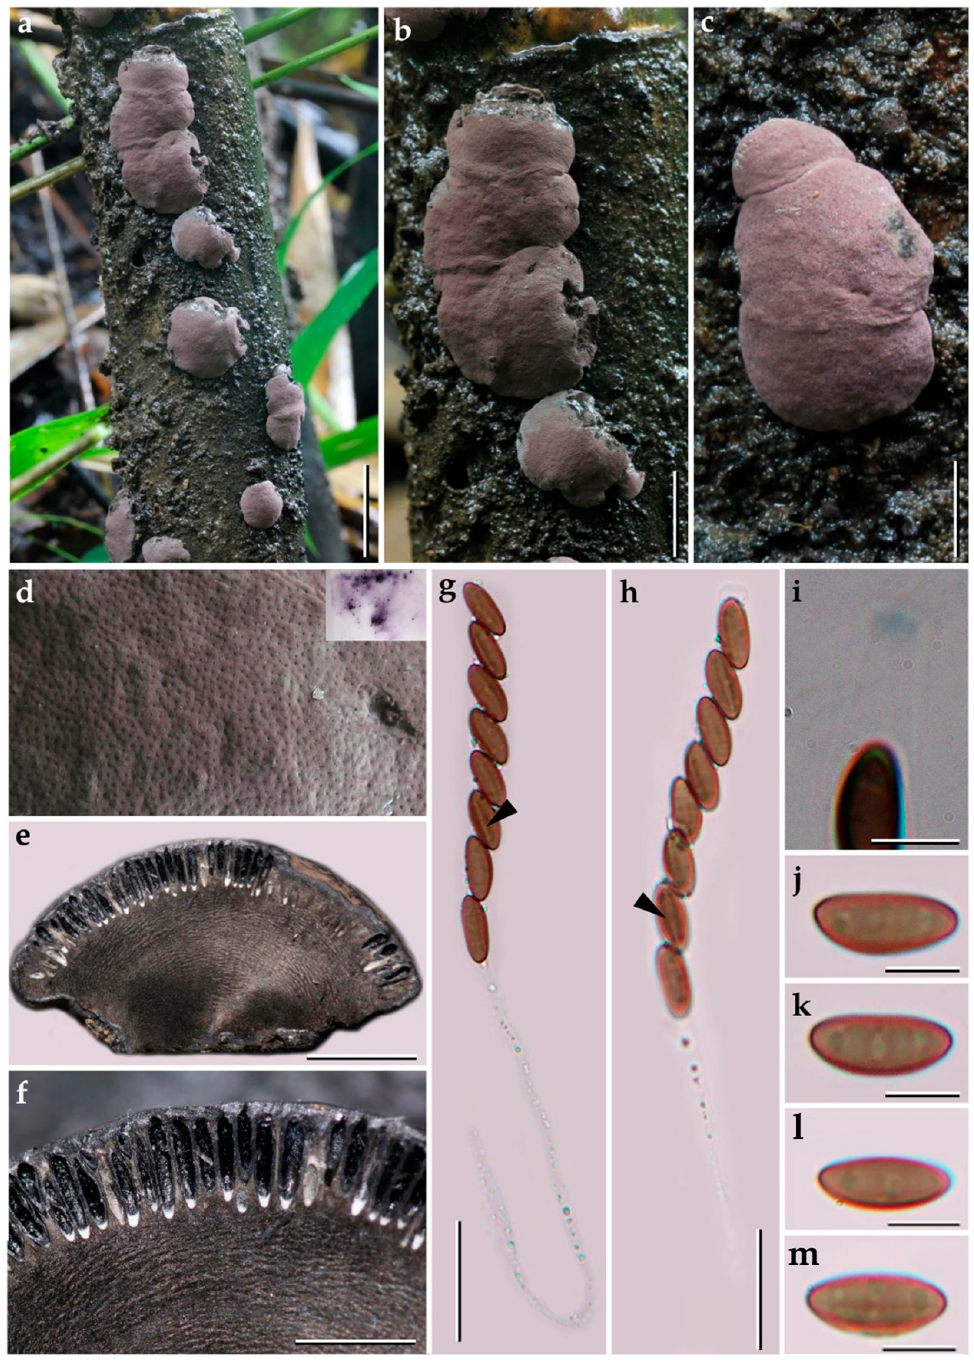
Figure 4. Morphological characteristics of Pyrenopolyporus bambusicola (BBH47923). ( a – c ) Stroma on bamboos; ( d ) stromal surface and ostioles with KOH-extractable pigments in 10% KOH; ( e ) longitudinal section of stroma showing perithecia and the tissue below the perithecial layer; ( f ) Perithecia; ( g , h ) asci showing germ slit (white arrows); ( i ) apical apparatus, bluing in Melzer’s reagent; ( j – m ) ascospores. Scale bars: ( a ) = 10 mm; ( b , c ) = 5 mm; ( e ) = 2 mm; ( f ) = 1 mm ( g , h ) = 20 µm; ( i – m ) = 5 µm.